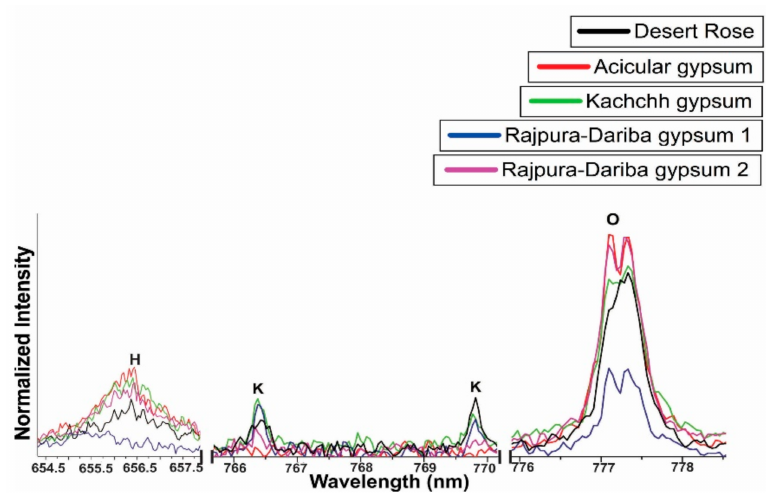
Figure 8. Spectral regions of recorded H, K, and O atomic data for the gypsum